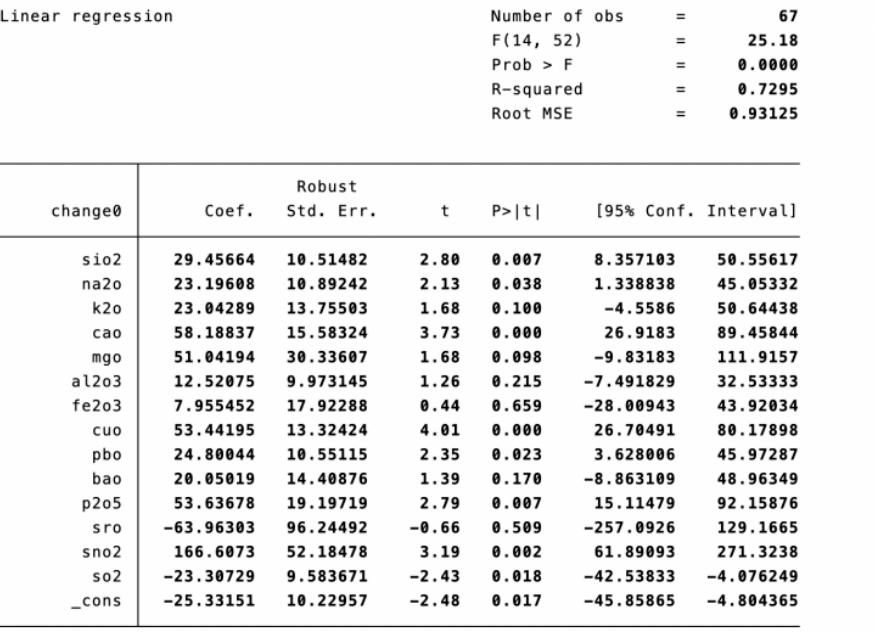
Figure 10. Components regression results of K-Means++ clustering.